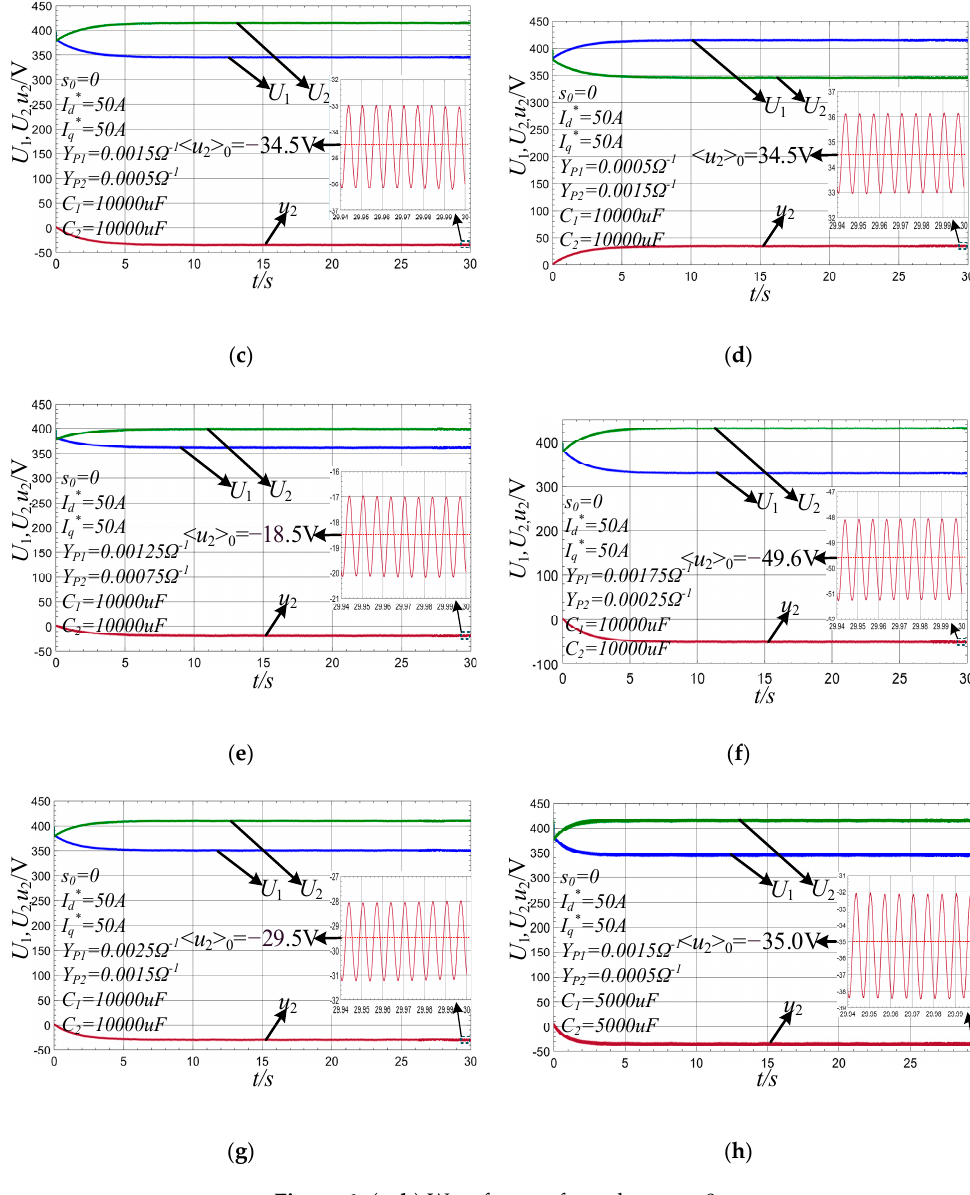
Figure 6. ( a – h ) Waveforms of u 2 when s 0 = 0. Table 4. Values of < u 2 > 0 when s 0 = 0.